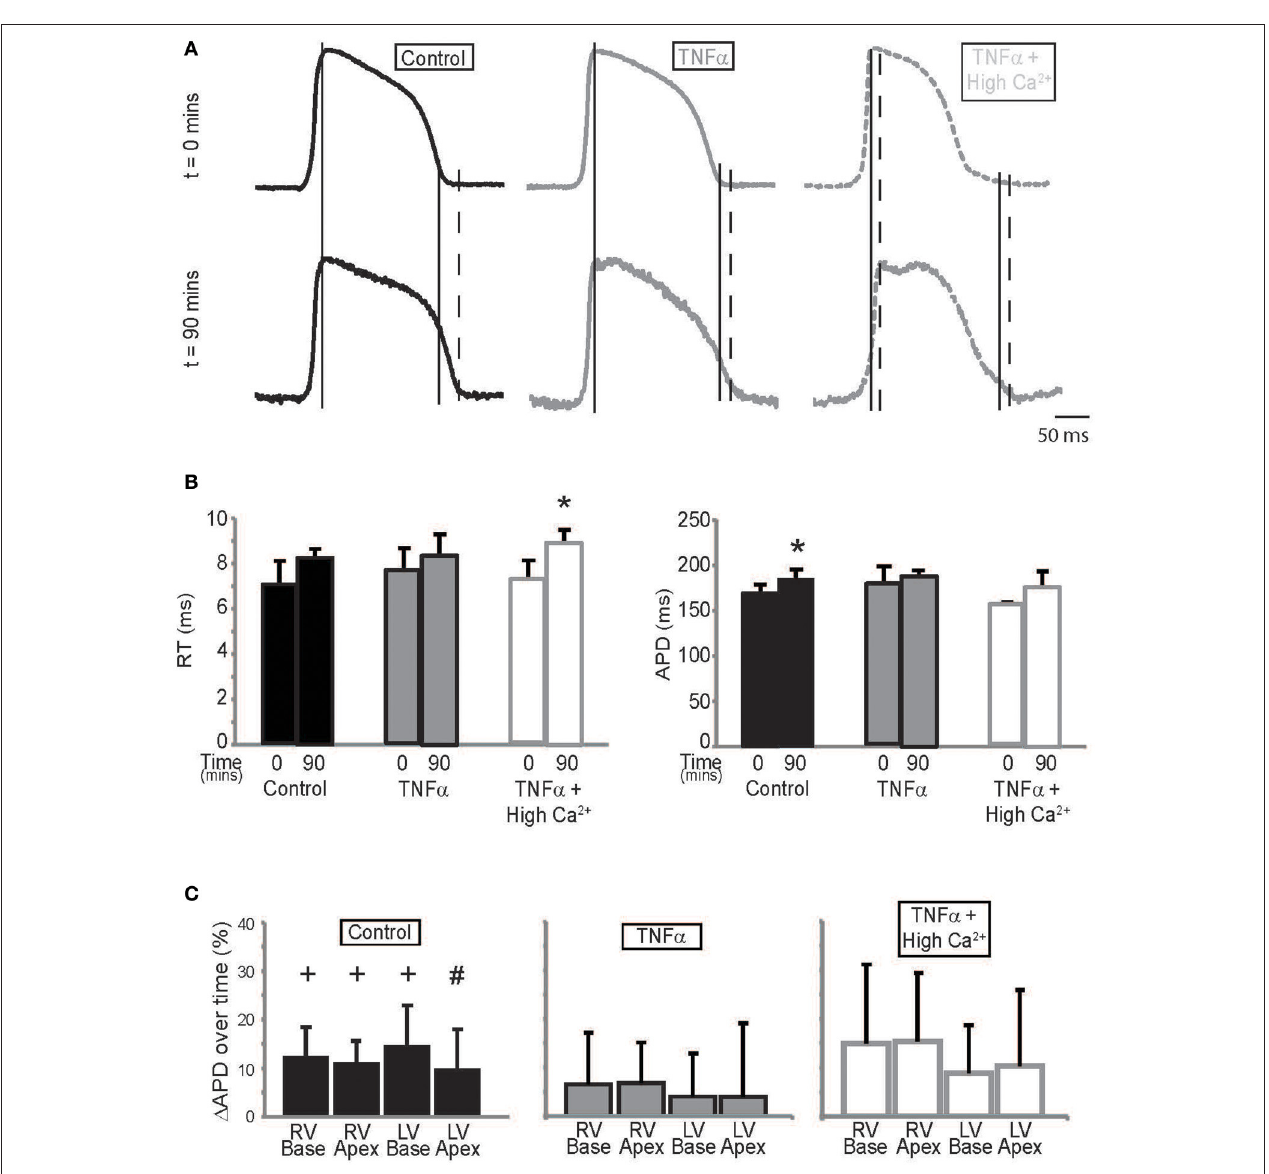
FIGURE 4 | Action potential parameters (A) Representative action potentials recorded from the anterior epicardium of control, TNF α , and TNF α + high calcium perfused hearts. Solid long lines indicate peak of AP relative to the time aligned beginning of the action potential. Solid and dashed short lines indicate fiducials in upper and lower panels respectively ( t = 0 and 90mins) and (B) Summary of RT (left) and APD (right) calculated from these hearts at t = 0 and 90mins. (C) APD quadrant analysis for hearts perfused with control Tyrode’s, TNF α and TNF α + high calcium. *Indicates p < 0.05 relative to t = 0 mins by paired comparison. + indicates p < 0.05 and # Indicates p = 0.05 relative to